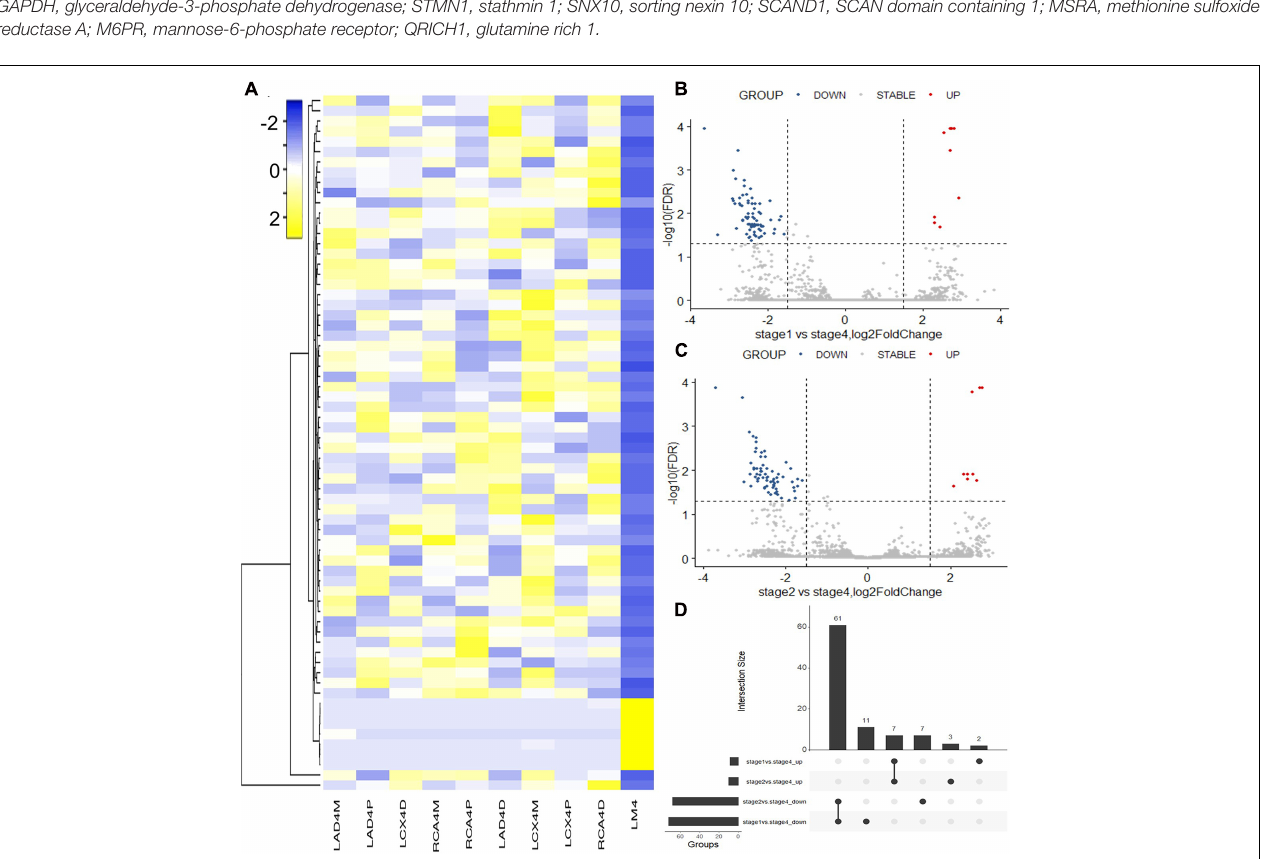
NSDHL, MSRA, SCAND1, UBXN6, QRICH1 , and